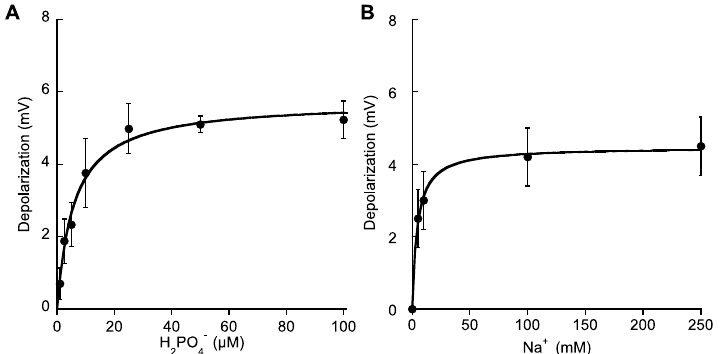
Figure 4. Membrane potential depolarizations induced by additions of micromolar H 2 PO 4 − concentrations. ( A ) Mean values of membrane depolarizations induced by increasing Pi concentrations in ASW containing 500 mM Na + . ( B ) Mean values of the membrane potential depolarizations induced by the addition of 25 μ M H 2 PO 4 − in ASW containing increasing Na + concentrations. Data were fitted to the Michaelis-Menten equation and kinetics parameters are shown in Table 2. Values are the means ± SD of five independent replicates.